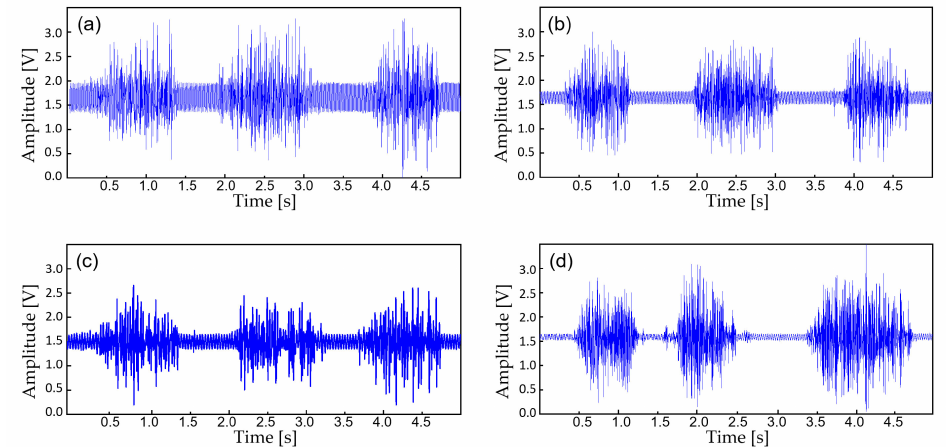
Figure 8. The biopotential signals with additional filtering. ( a ) Raw EMG acquired from the AFE at 30 cm away from the wall power; ( b ) EMG filtered with an analog notch filter (twin-T); ( c ) EMF filtered with an IIR digital filter; ( d ) EMG filtered with ( b , c ).